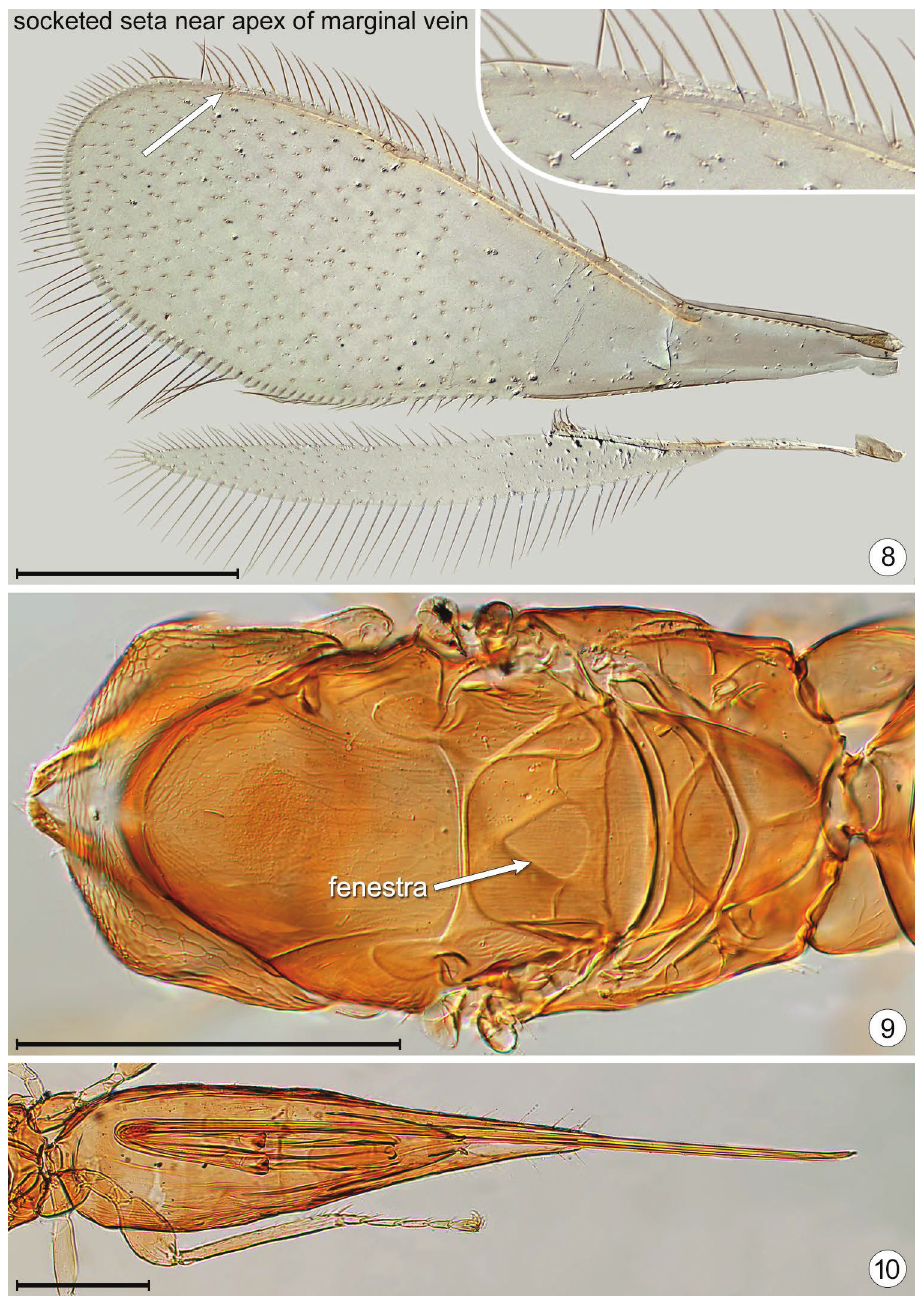
Figures 8–10. Eustochomorpha haeckeli , female. 8, wings 9 mesosoma, dorsal 10 metasoma, dorsal. Scale bar = 200